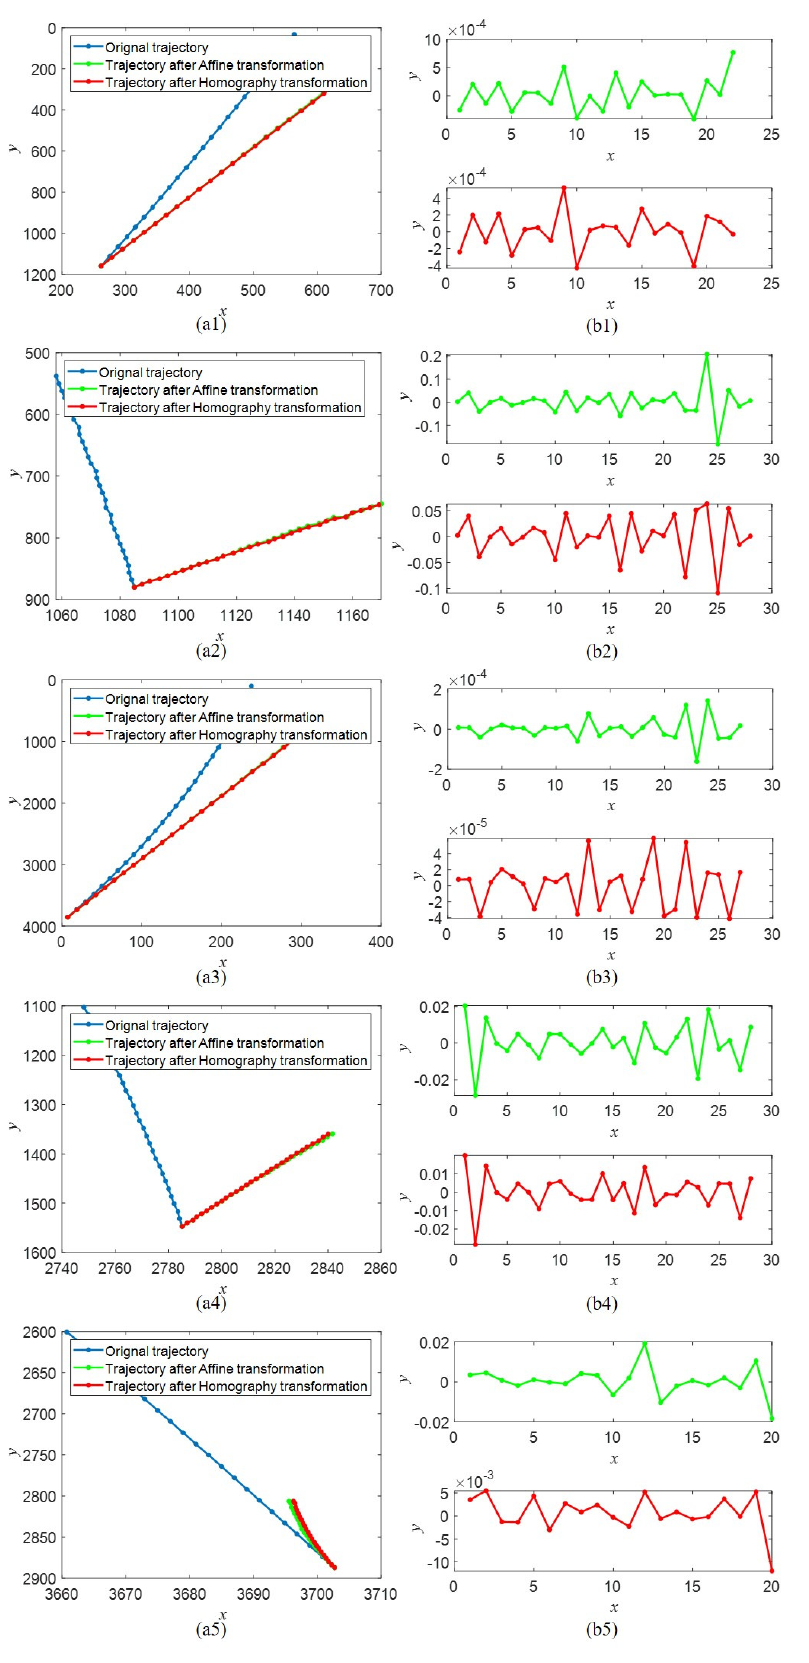
Figure 12. The results of ( a1 – a5 ) fitting trajectories and ( b1 – b5 ) corresponding curvature changes in different